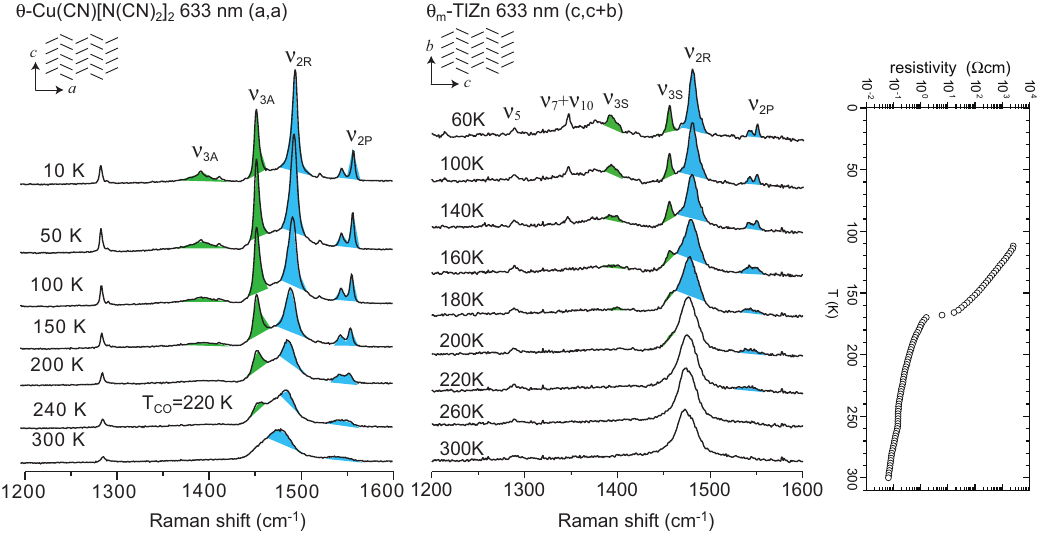
Figure 12. Temperature dependence of the Raman spectrum of θ -(BEDT-TTF) 2 Cu(CN)[N(CN) ] (left) and θ -(BEDT-TTF) TlZn(SCN) (middle) along with the 2 2 m 2 4 electrical resistivity. The inset shows the herringbone arrangement of BEDT-TTF with respect to the crystallographic axes. The spectral change and resistivity are rather continuous. The left spectrum is modified from Figure 5 of ref. [57]. The right spectrum is modified from Figure 7 of ref.